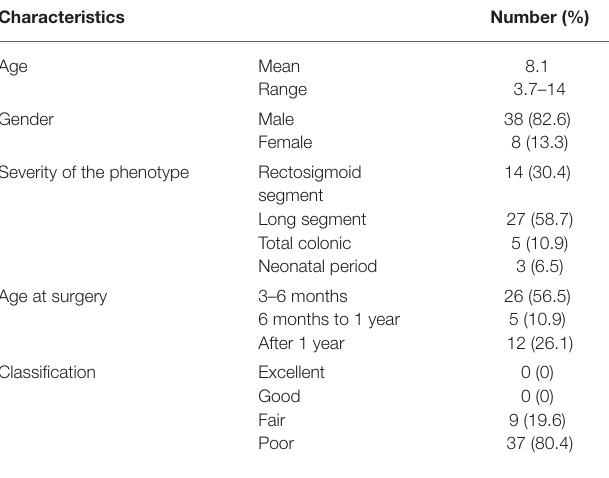
TABLE 2 | Demographic characteristics and clinical spectrum of